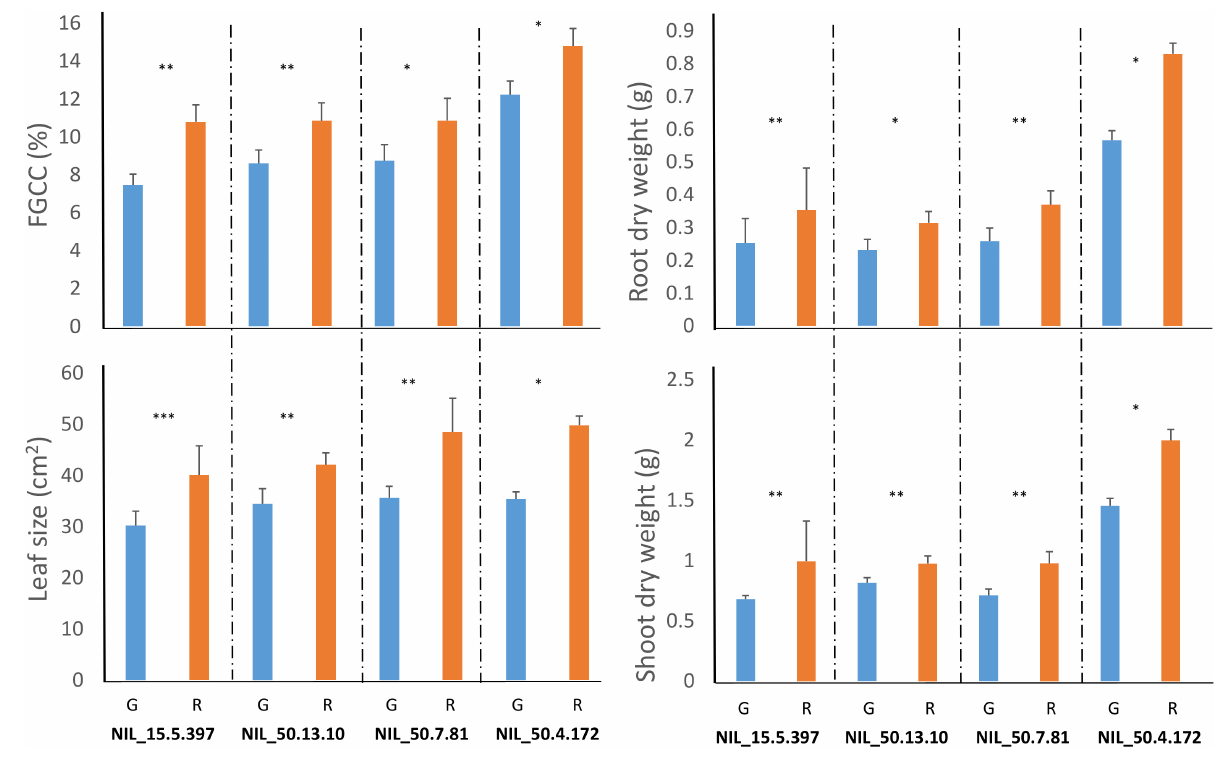
FIGURE 1 | Phenotypic analysis in four heterogeneous inbred family (HIF)-derived near-isogenic line (NIL) pairs harvested after 4 weeks of growth in a greenhouse. G, Genesis836 allele and R, Rupali allele at Ca4_Vqtl . FGCC, Fractional Green Canopy Cover (%) using imaging analysis with the Canopeo application (Oklahoma State University, Stillwater, OK, United States; https://canopeoapp.com/). Student’s t -test was used to identify significant differences between lines from each NIL pair ( n = 4). Student’s t -test significance codes: ∗ P < 0.05, ∗∗ P < 0.01, and ∗∗∗ P <